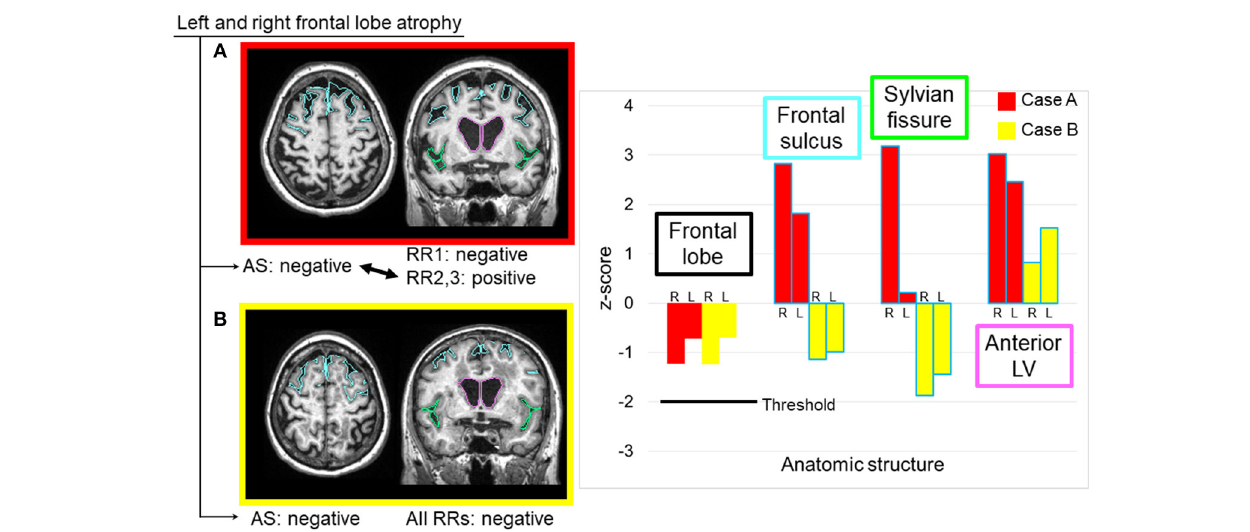
FIGURE 5 | Two sample cases with similar z-scores for the frontal lobe volumes, but with different interpretations by radiologists. Two radiologists reported bilateral frontal lobe atrophy in Case (A) , where the image showed noticeable expansions of the bilateral frontal sulci and unilateral Sylvian fissure, as well as a highly dilated anterior lateral ventricle. All radiologists considered the frontal lobe to be normal in Case (B) , where the image showed relatively smaller frontal sulci and Sylvian fissures, and moderately dilated anterior lateral ventricles. AS, automated sentence; L, left; LV, lateral ventricle; R, right; RR, radiologic